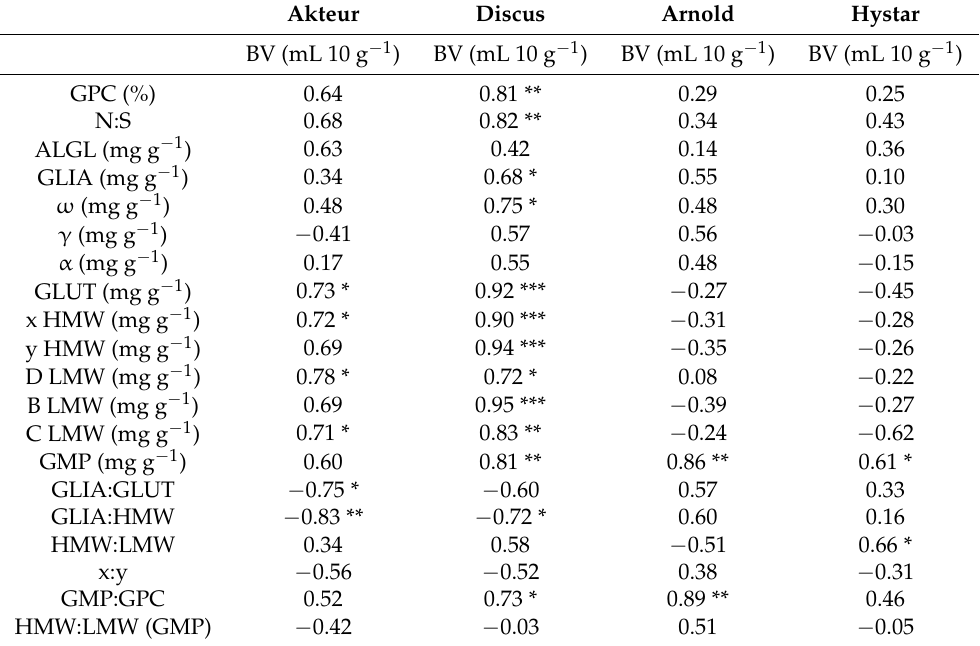
Table 5. Pearson correlation coefficients between baking volume and GPC, N to S ratio of the grain, amount of the different grain protein fractions, and ratios between different grain protein fractions. Asterisks and bold numbers indicate significant correlations (*, p < 0.05; **, p < 0.01; ***, p < 0.001). Akteur Discus